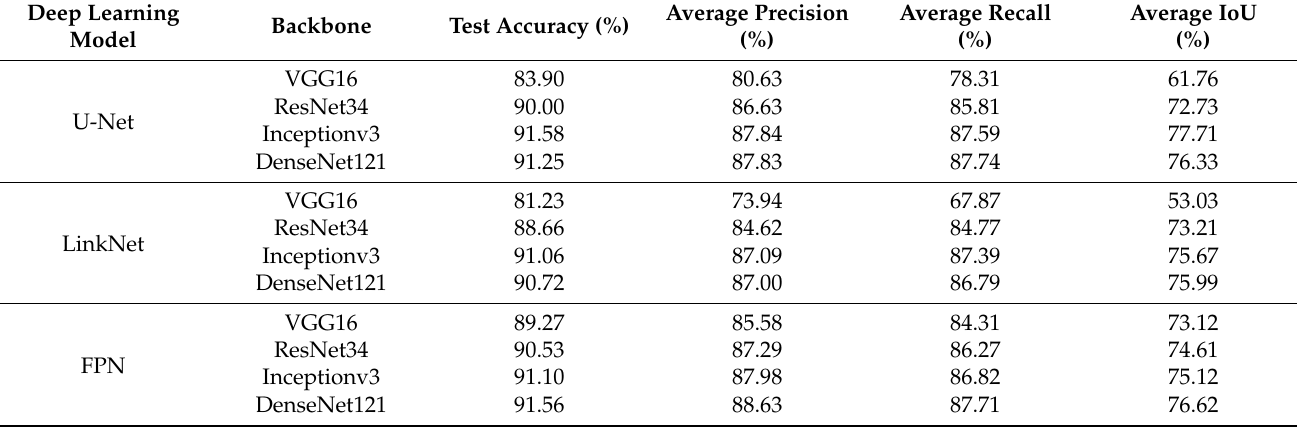
Table 2. Performance summary of the U-Net, LinkNet, and FPN models and backbones in the testing